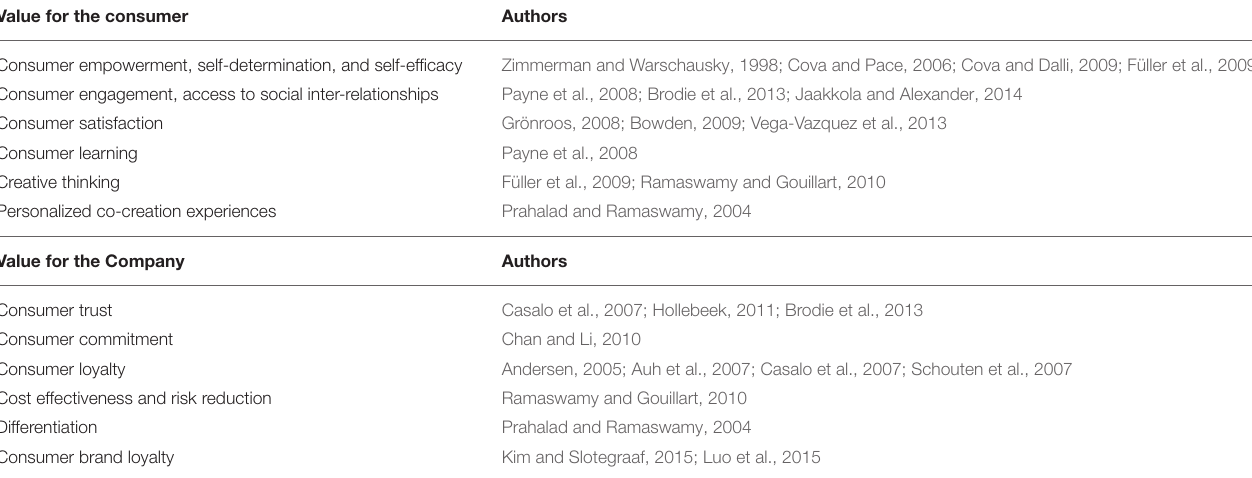
TABLE 5 | Positive effects of